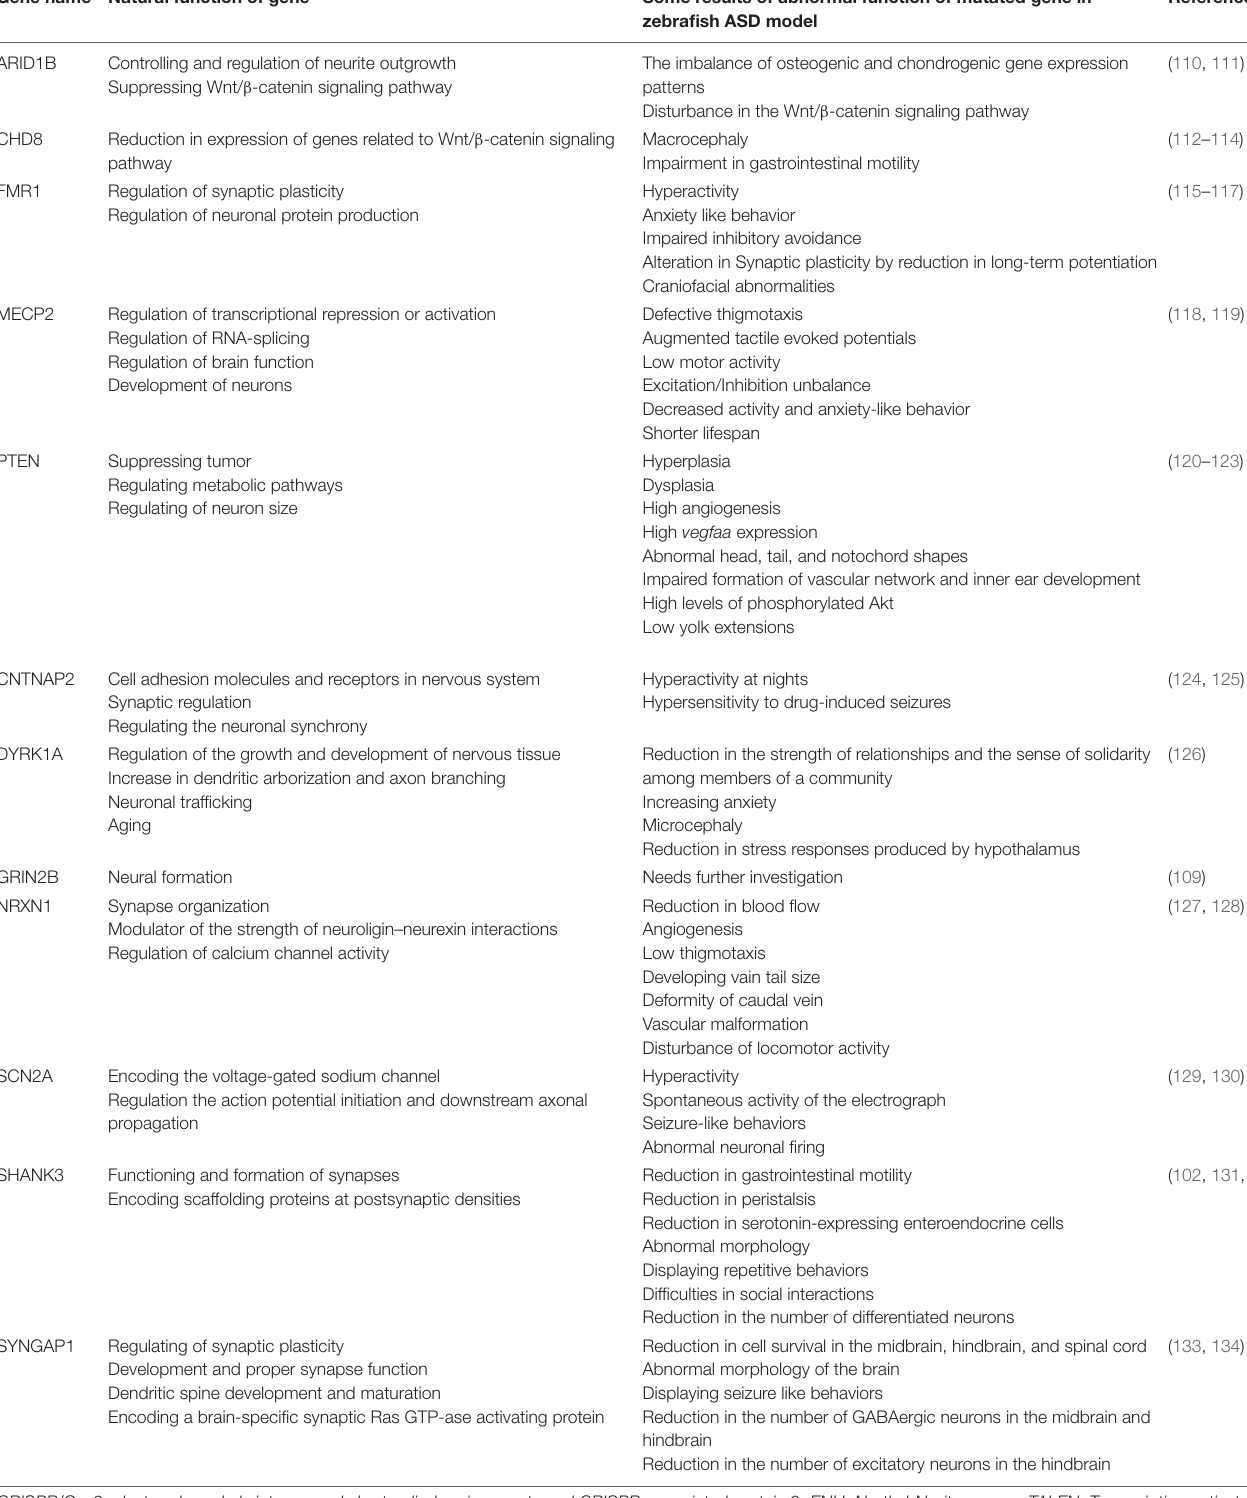
Some results of abnormal function of mutated gene in zebrafish ASD